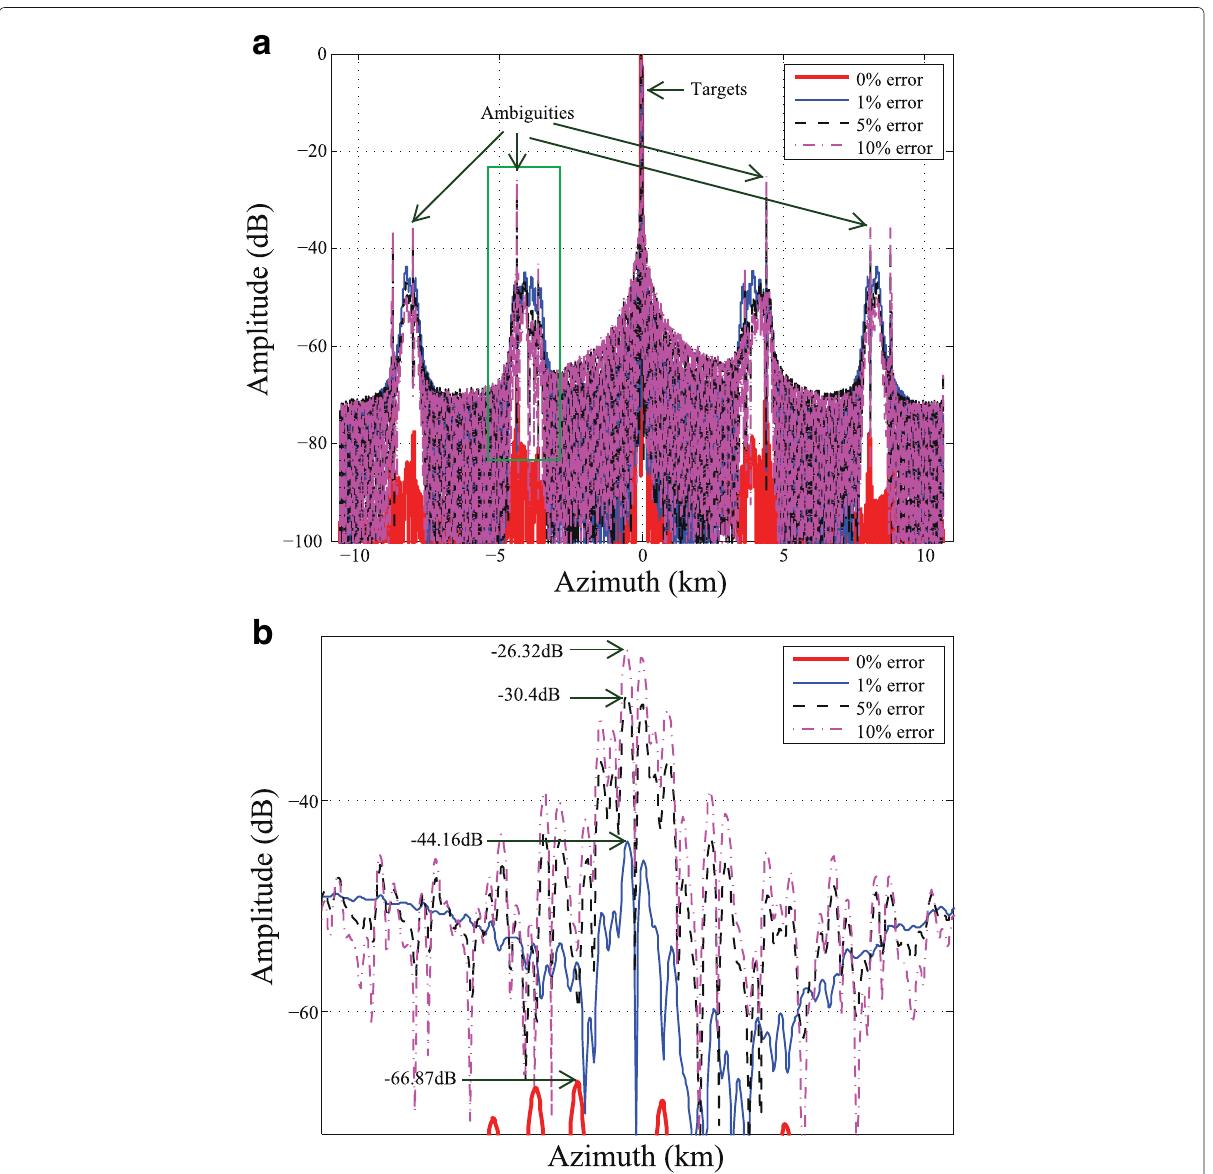
Fig. 11 Profiles of the azimuth PSFs for multichannel SAR when there are estimation errors in F p . The azimuth PSFs for the point target and ambiguitites; b Enlarged view of the ambiguities in the green rectangle of